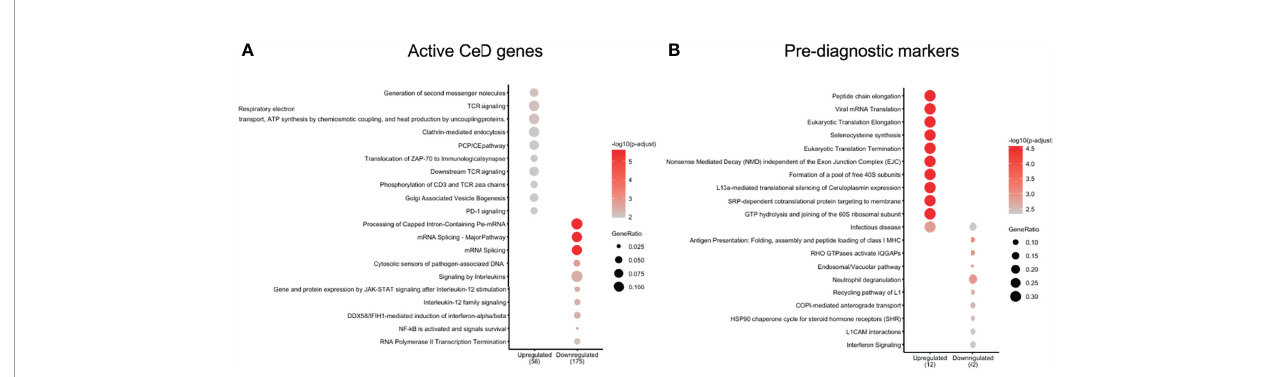
FIGURE 4 | CD4 T cells show important DEGs associated with multiple immune-related pathways. Pathways enriched in (A) active CeD and (B) pre-diagnosis markers in CD4+ T cells identi fi ed using the Reactome database (P value < 0.05). Pathways are on the vertical axis. At the bottom is the direction of expression of the DEGs in CD4+ T cells. Numbers in brackets indicate the number of DEGs present in all enriched pathways. The size of dot indicates the ratio of the number of genes present in the gene set to the total number of genes used in each pathway.